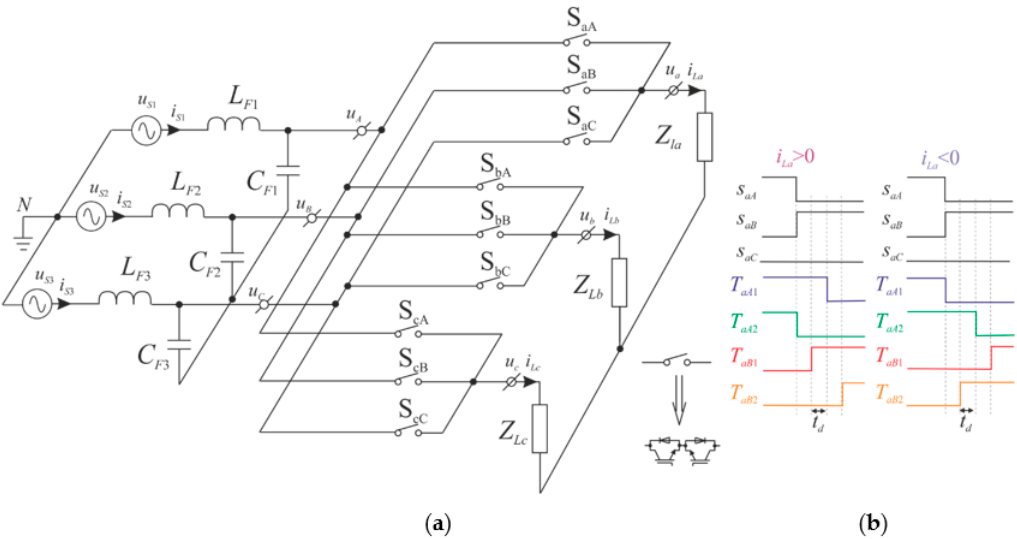
Figure 1. Topology of direct matrix convertor (MC) with input low-pass inductor-capacitor (LC) filter: ( a ) the main circuit; ( b ) four step example of switch commutation.